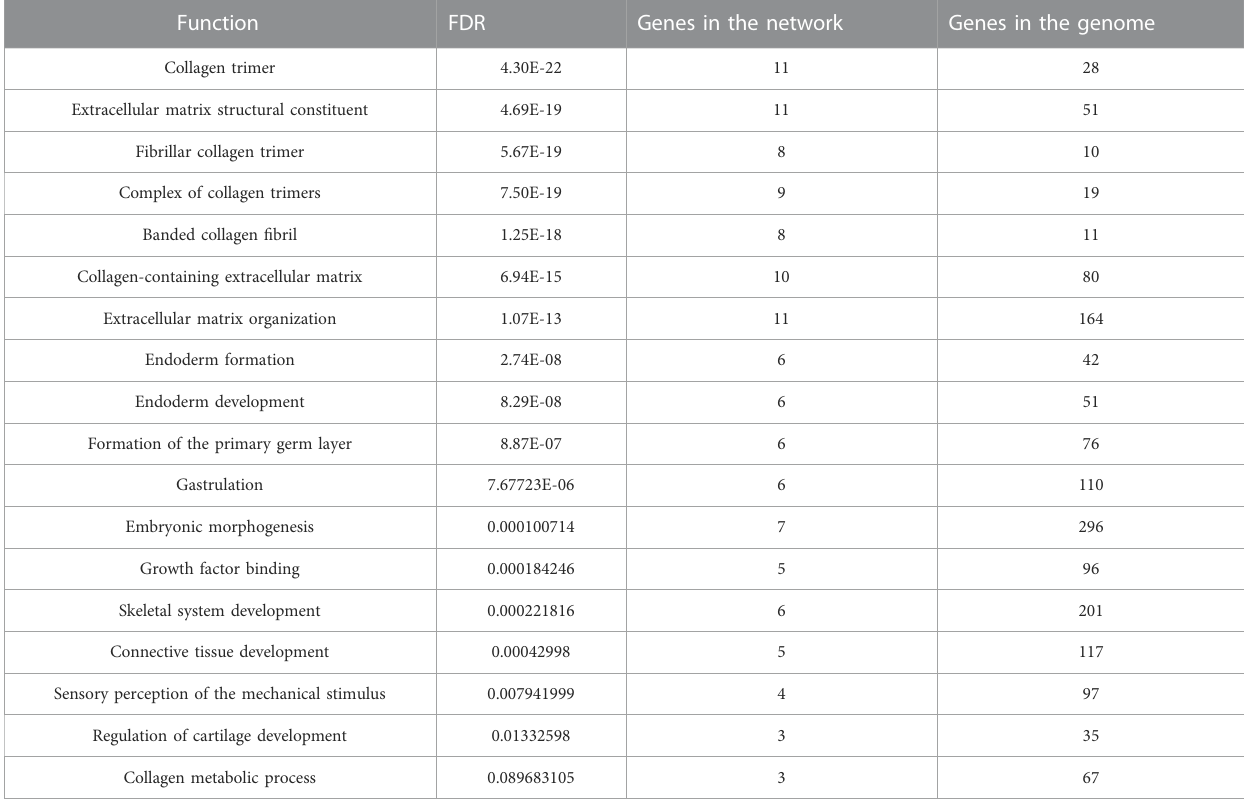
TABLE 3 Gene functions analyzed using GeneMANIA.